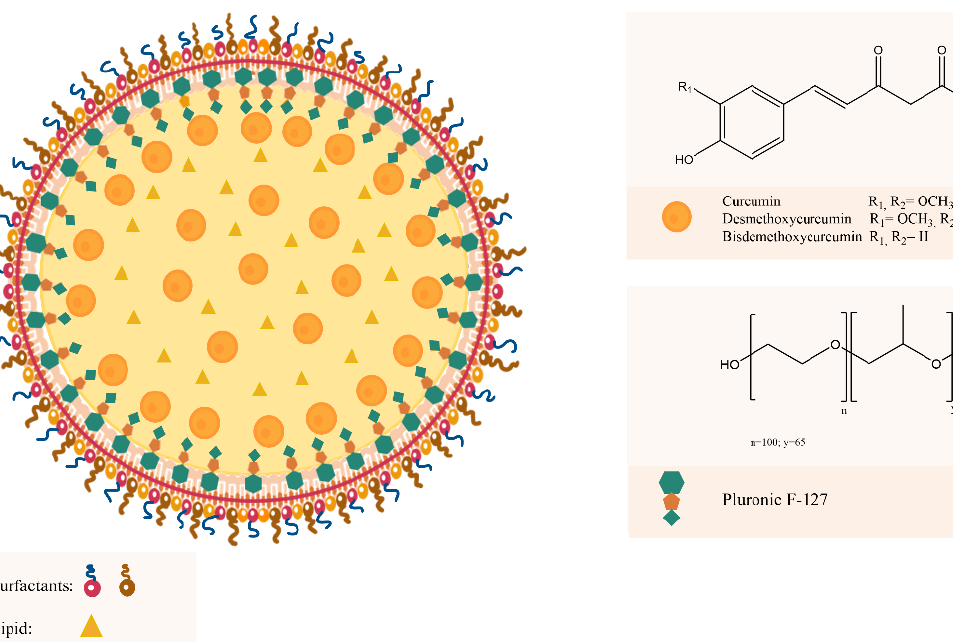
Figure 1. Schematic representation of PLHNs and chemical structure of Pluronic F-127, CUR, DMC, and BDM. For drug delivery and PN preparation, poloxamers, a polyethylene oxide-polypropylene oxide-polyethylene oxide (PEO-PPO-PEO)-based triblock, commercialized under the Pluronics ® trademark is one of the most used copolymers [9,10]. Its monomers can render an am- phiphilic character in an aqueous solution based on the PEO solubility in water and the PPO insolubility. The PEO blocks are thus hydrophilic, while the PPO block is hydropho- bic [11,12]. Besides leading to surface active properties, the block segregation also gives rise to self-assembly useful nanostructures [11]. Pluronic F-127 (PEO 100 –PPO 65 –PEO 100